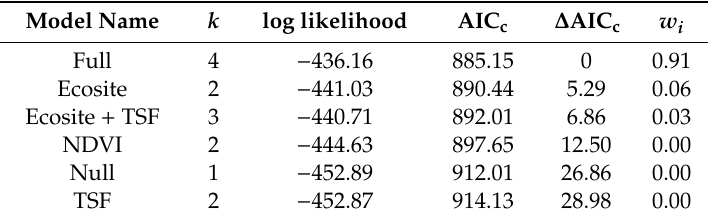
Table A5. Ranking of candidate models used to create the canopy closure layer for modelling lichen presence and abundance. k = number of fixed effects ( + 1 for intercept), w i = Akaike weight. TSF = time-since-fire, NDVI = normalized difference vegetation index.